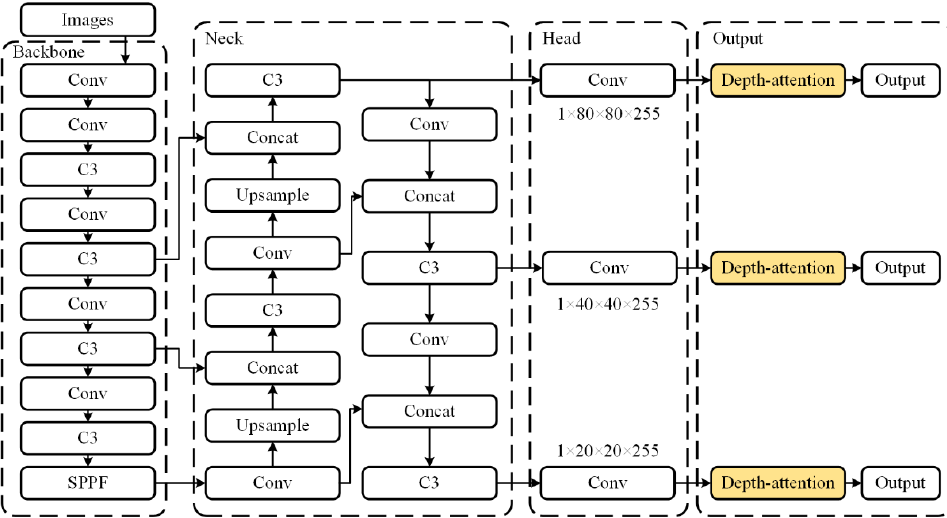
Figure 11. The structure of depth-attention YOLOv5. The network consists of four main parts: input, backbone, neck, head, and output. (The yellow part is the added depth-attention).